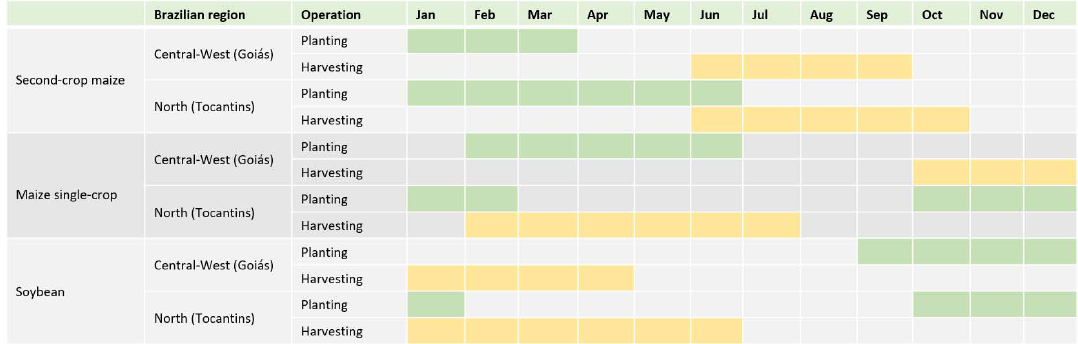
Figure 5. Planting (represented in green) and harvesting (represented in yellow) periods for soybean and maize in Central-West and North regions of Brazil (Adapted from the “Calend á rio de Plantio 2015” of the Brazilian Ministry of